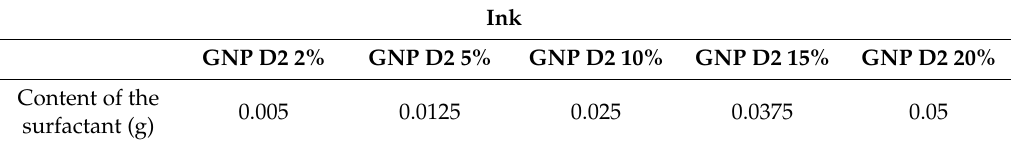
Table 4. Weight content of the surfactant in the ink composition for a 50 g sample.